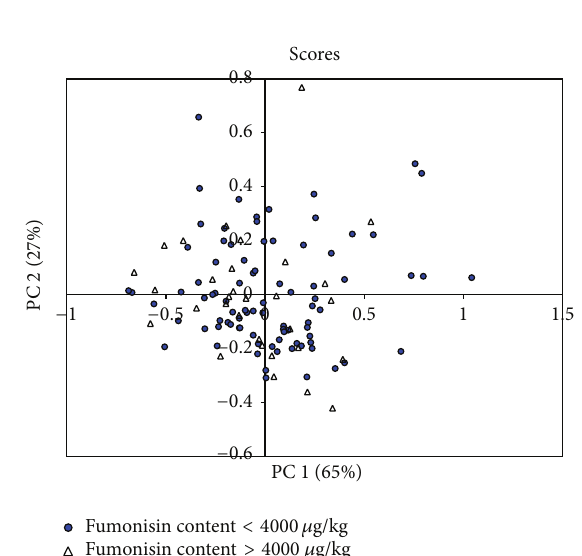
Figure 7: Scatter plot of first two principal components (PC 1 and PC 2) for all spectra. The variance explained by each principal component is indicated in parentheses.